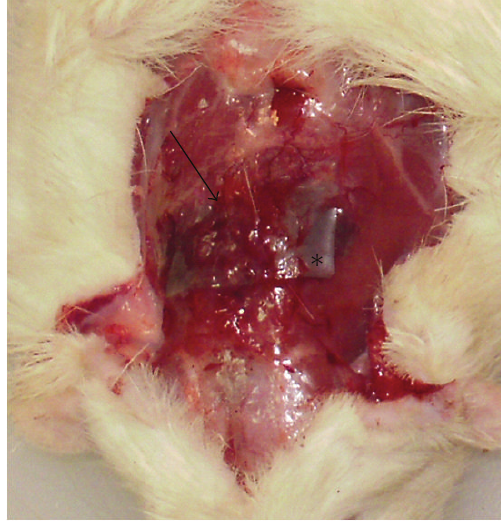
Figure 1: In vivo appearance of PP on the 30th day of implantation. There is a thick and hard capsule (black arrow) around the polymer film